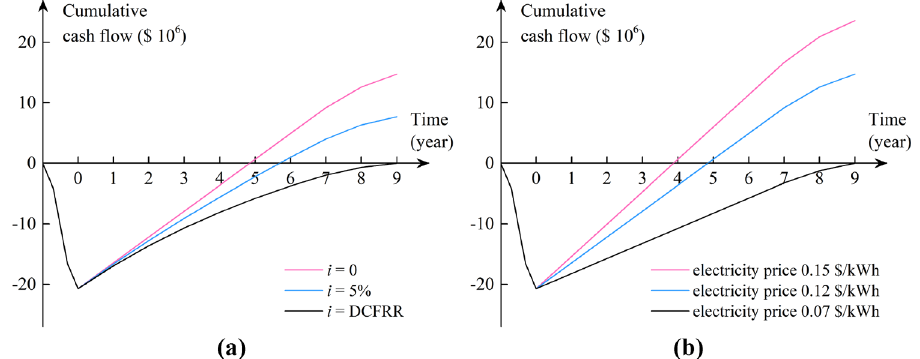
Fig. 4 Cash flow pattern for different interest rates ( a ) and different electricity prices ( b